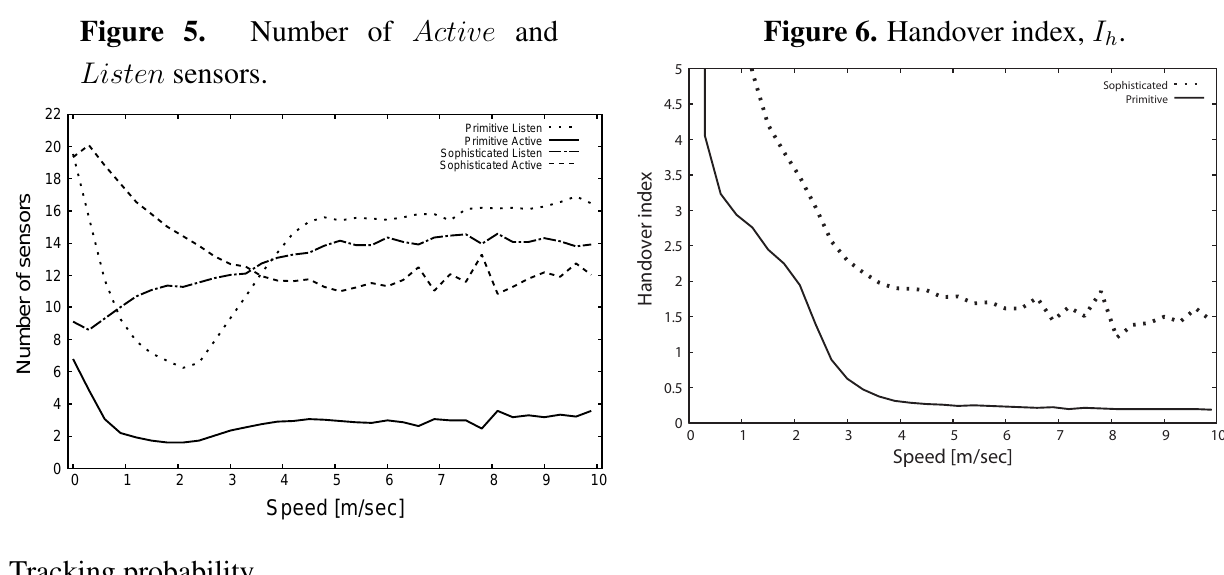
Figure 6. Handover index, I